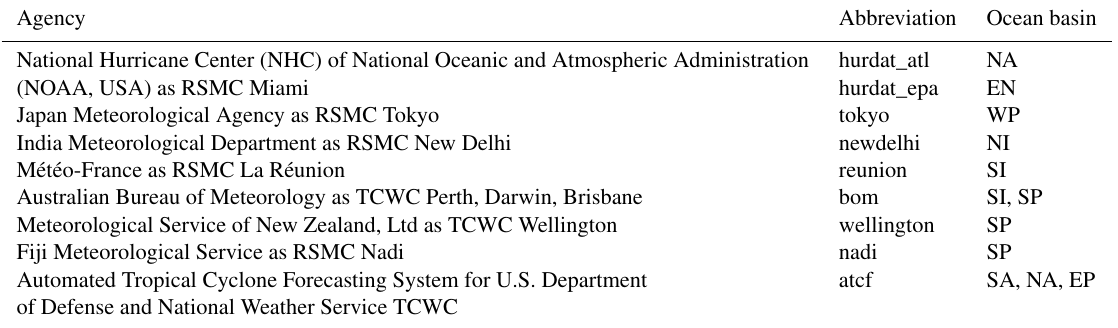
Table 1. The list of main agencies included in the IBTrACS dataset in the different ocean basins: North Atlantic (NA), eastern North Pacific (EN), western North Pacific (WP), north Indian (NI), south Indian (SI), South Pacific (SP), South Atlantic (SA). Agency Abbreviation Ocean basin National Hurricane Center (NHC) of National Oceanic and Atmospheric Administration